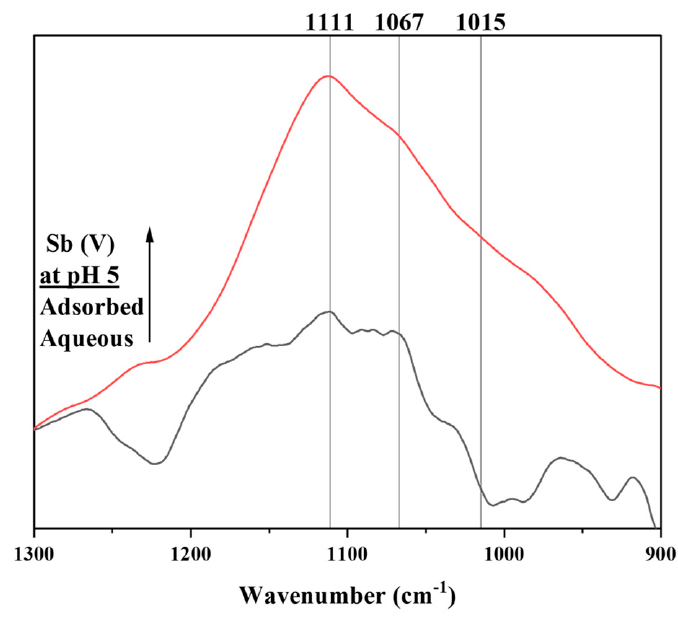
Figure 2. Normalized in situ ATR-FTIR spectra of adsorbed and dissolved Sb (V) at pH 5.